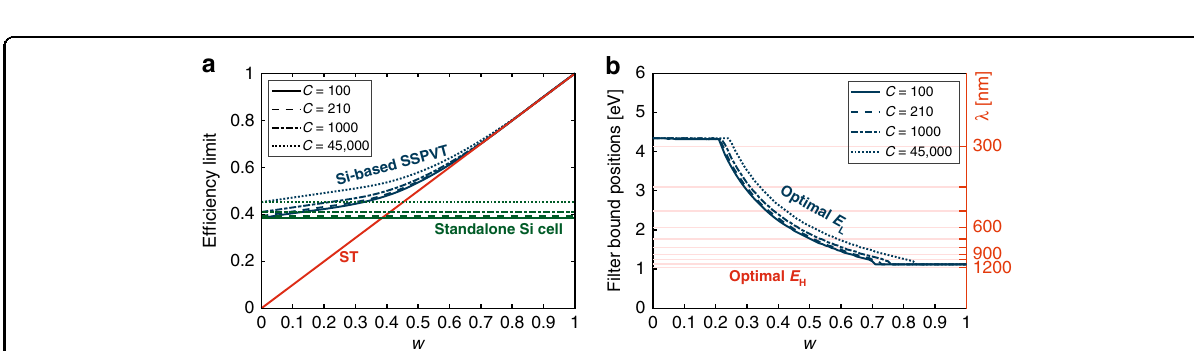
Fig. 9 a Total effective ef fi ciency limit of Si-based SSPVT collectors, standalone Si cells and ST collectors, and b optimal spectral-splitting fi lter of SSPVT collectors with Si solar